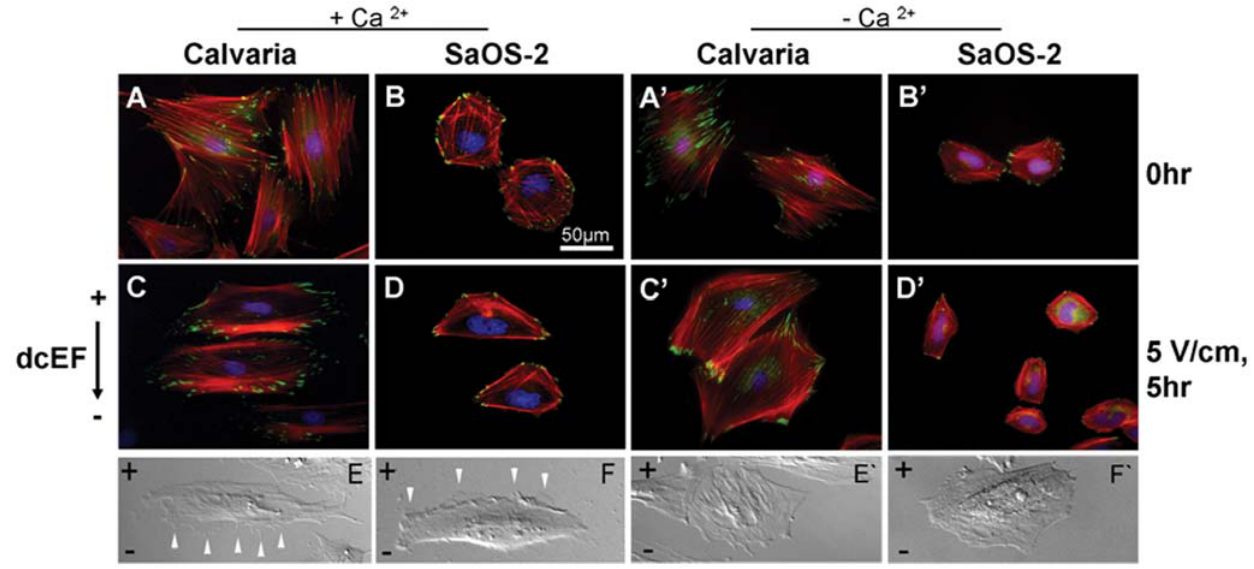
Figure 3. Redistribution of adhesion proteins (vinculin and actin) and de novo formation of membrane protrusions during dcEF (5 V/cm, 5 h) exposure. Fluorescent images of calvaria and SaOS-2 cells stained with phalloidin. TRITC, vinculin and DAPI mark actin filaments, focal contacts and nuclei, respectively before (A,B) and after (C,D) dcEF exposure in the presence, (A’,B’) or (C’,D’) absence of Ca 2 + ions. DIC micrographs of elongated calvaria and SaOS-2 cells with newly formed membrane protrusions (white arrows) on their leading edges in presence of Ca 2 + ions (E,F) or cells with randomly distributed protrusions absence of Ca 2 + (E’,F’).